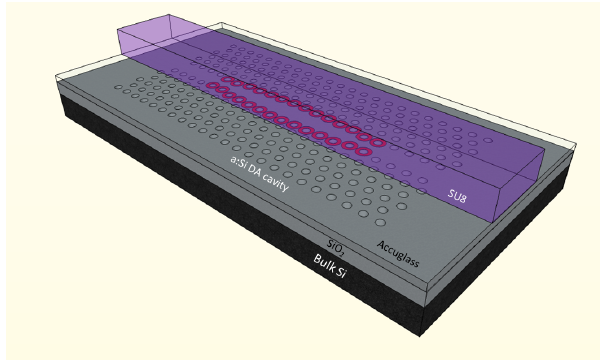
Figure 2. Schematic of the fabricated PhC cavity showing polymer waveguide sitting on PhC cavity.